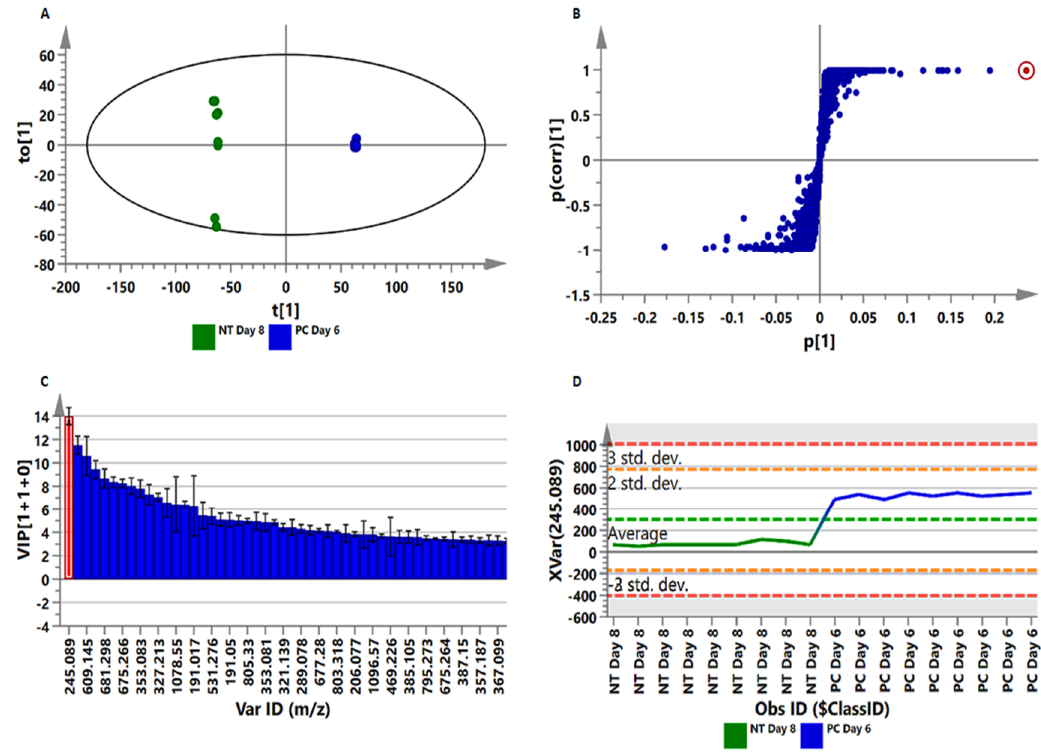
Figure 4. Orthogonal-partial least square discriminant analysis (OPLS-DA) modelling and variable / feature selection of tomato plants infected with Phytophthora capsici; leaf data acquired in ESI − mode. ( A ): A typical OPLS-DA score plot separating non-treated (NT) day 8 plants vs. P. capsici (PC)-treated day 6 plants (1 + 1 + 0) components, R 2 X = 0.802, Q 2 = 0.999, CV-ANOVA p -value = 1.3 × 10 − 19 ). ( B ): An OPLS-DA loadings S-plot for the same model in A; only variables with the correlation [ (p(corr) ] ≥ |0.6| and covariance (p1) ≥ |0.05| were chosen as discriminating variables, and identified using the m/z to generate an elemental composition. ( C ): A variable importance in projection (VIP) plot for the same model, pointing mathematically to the importance of each variable in contributing to group separation in the OPLS-DA model. ( D ): A typical variable trend plot (of the selected variable in VIP and S-plots), displaying the changes of the selected variables across the samples (NT day 8 vs. PC day 6). This shows that the selected features significantly discriminated the treated from the control samples. Similar figures (both ESI − and ESI + ) were generated for stem (site of inoculation) and root tissue, presented as Figures S11–S15. For extraction of the signatory biomarkers responsible for the observed sample separation on OPLS-DA, the loadings S-plot (a selection method for variables) (Figure 4B and Figures S11B–S15B) was used for feature selection. To validate the significance of the latter, variable importance in projection (VIP) plots (Figure 4C and Figures S11C–S15C) were used, and variables with a score of >1 were considered as significant (and subsequently selected for compound annotation). VIP plot evaluation prevents bias in the selection of variables, and helps to describe the importance of the variables to the model [41]. Lastly, a variable trend plot (Figure 4D and Figures S11D–S15D) of the S-plot and VIP plot selected variable (highlighted in red) was computed to evaluate the change of the selected feature across the samples (NT vs. PC). Various models (both PCA and OPLS-DA), comparing the metabolomes from different days (PC day 2–8) against controls (NT days 2 and 8) were generated. Due to the large number of graphs generated, not all can be shown. The features found to distinguish NT from PC were then selected for compound annotation. Owing to the lack of commercially available authentic standards, annotations represent putative identifications with assigned features at a metabolite identification (MSI) level-2 annotation [47,48], and are